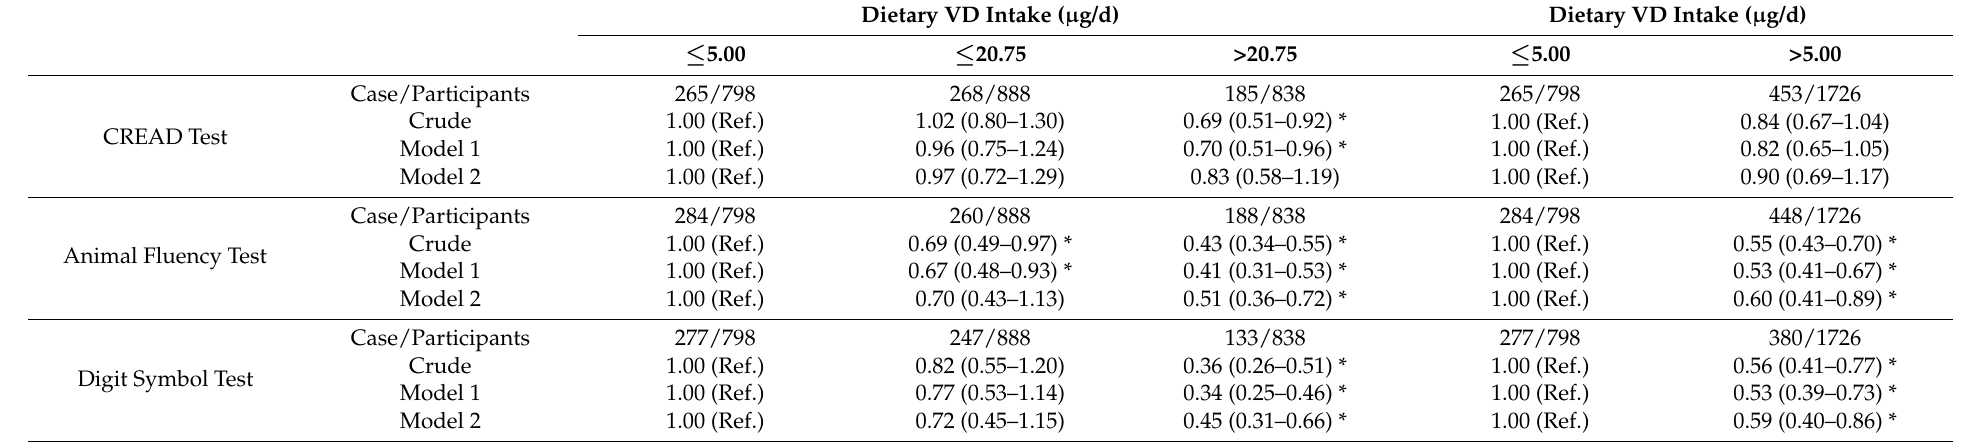
Table 4. Weighted ORs (95%CI) for scores on the Consortium to CERAD test, Animal Fluency test, DSST across dietary VD intake, NHANES 2011–2014 (N =